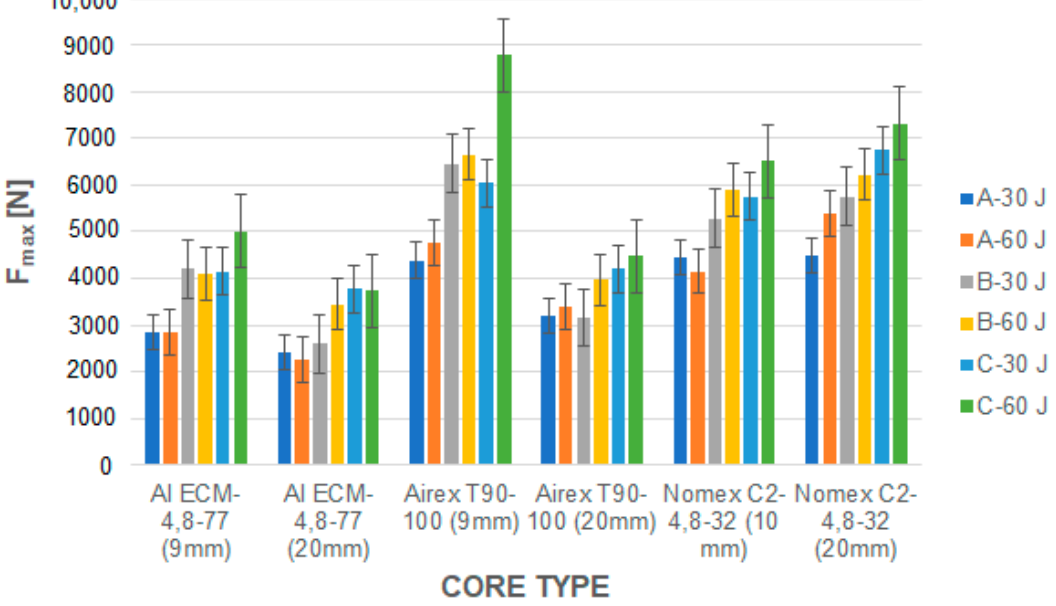
Figure 20. A survey of maximum forces at the impact test. Sandwich constructions with t c = 20 mm thick cores. A comparison with the structures t c = 10 mm thick cores.